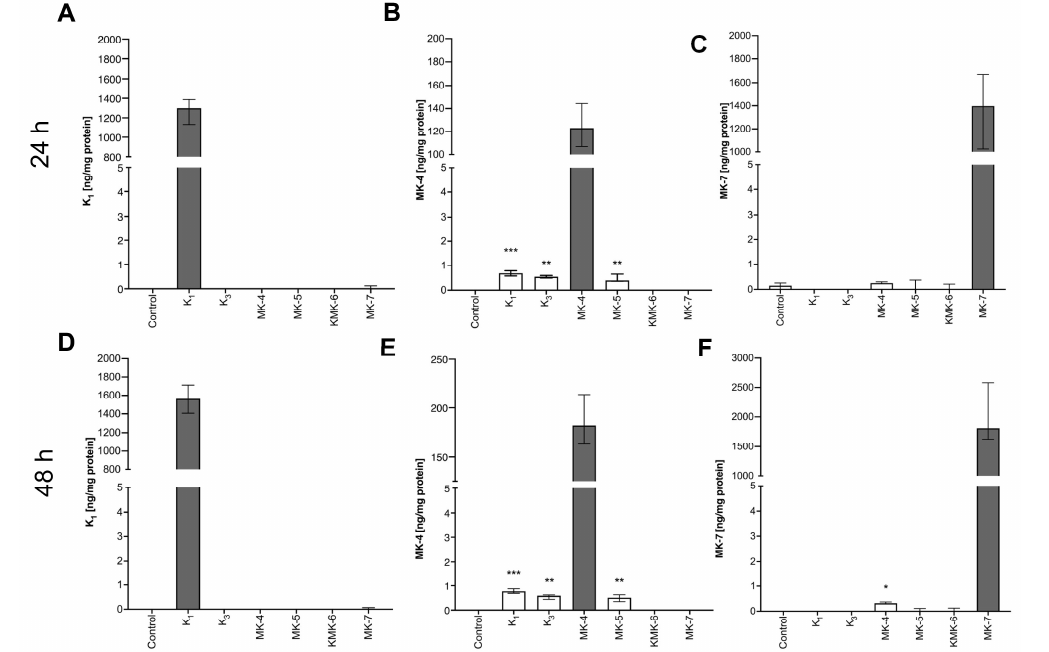
Figure 3 Figure 3. The intracellular concentration of vitamins K 1 , MK-4 and MK-7 in RAW 264.7 cells treated with 10 µ M exogenous vitamins K (K 1 , K 3 , MK-4, MK-5, MK-6 and MK-7). To assess the interconversion of exogenous vitamins K to endogenous MK-4, RAW 264.7 cells were incubated 24 and 48 h with various forms of exogenous vitamins K. Then, the concentrations of K 1 ( A , D ), MK-4 ( B , E ) and MK-7 ( C , F ) were measured in cell lysates using the UHPLC-MS/MS method. Data are shown as median and IQR of three independent experiments and technical replicates ( n = 9). Statistical significance was evaluated by the Kruskal Wallis test followed by Dunn’s post hoc multiple comparisons using GraphPad Prism 9 software. The symbols *, ** and *** indicate statistical significance at p < 0.05, 0.01 and 0.001, respectively. The measured vitamins K, which was added exogenously to the medium, were excluded from the statistical analysis (indicated by the black in the graph). To confirm that endogenous MK-4 may be produced from exogenous K 1 and K 3